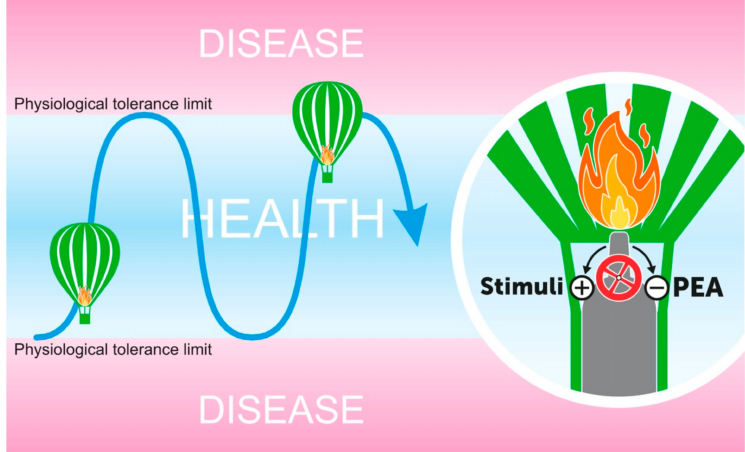
Figure 4. The prohomeostatic function of PEA: A conceptual view. Just like a hot air balloon floating in the sky, tissue homeostasis requires persistent monitoring and adjustments as conditions